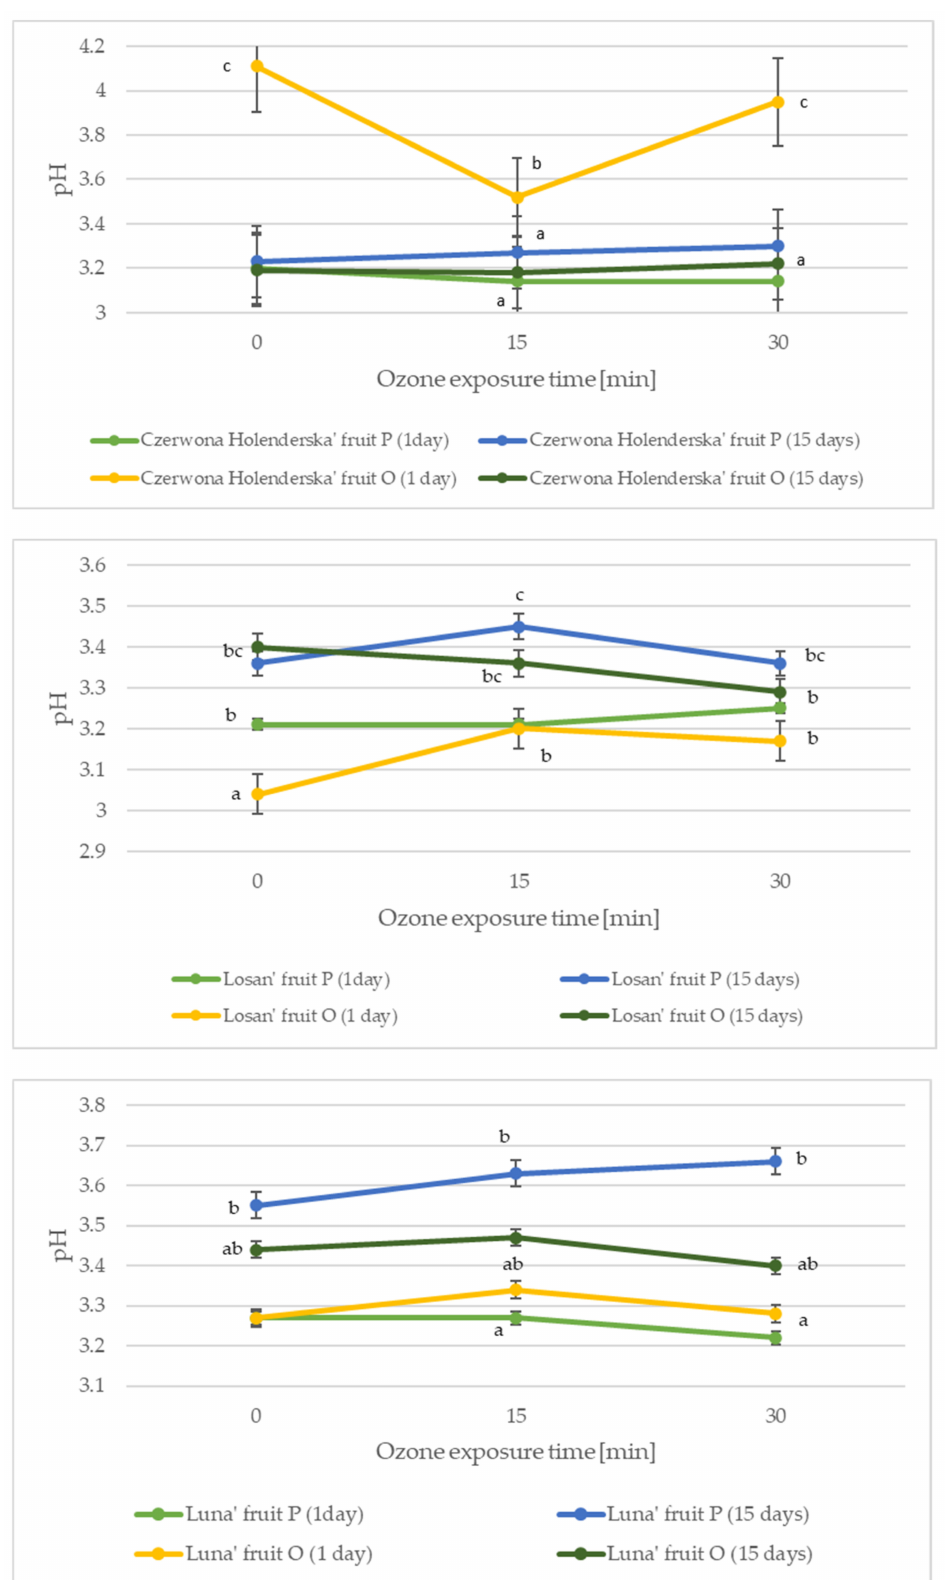
Figure 2. Changes in the pH of red currant fruit depending on the harvest date, variety, and ozone exposure time. Data are expressed as mean values (n = 3) ± SD; SD—standard deviation. Mean values with different letters are significantly different ( p <